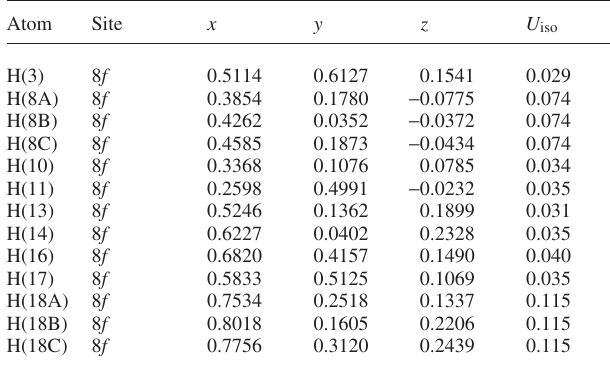
Table 2. Atomic coordinates and displacement parameters (in Å 2 )